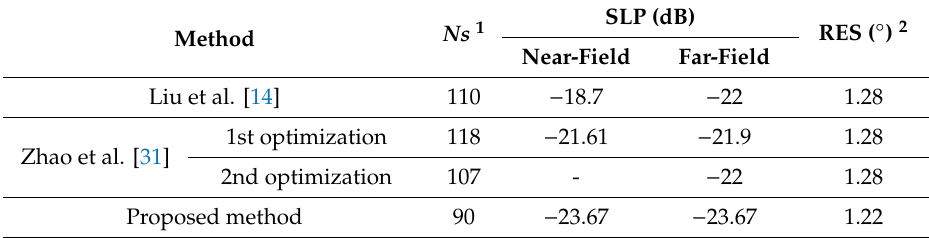
Table 1. Comparisons of sparse cross array synthesis results among the proposed method and the existing methods.